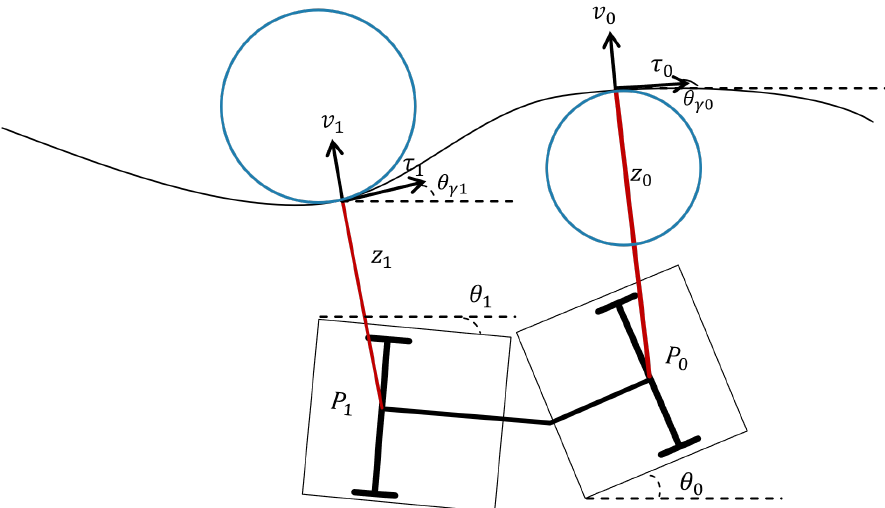
Figure 9. Projection of the axle midpoints onto the path. The Frenet frames coordinate axes ( v i , τ i ) are also